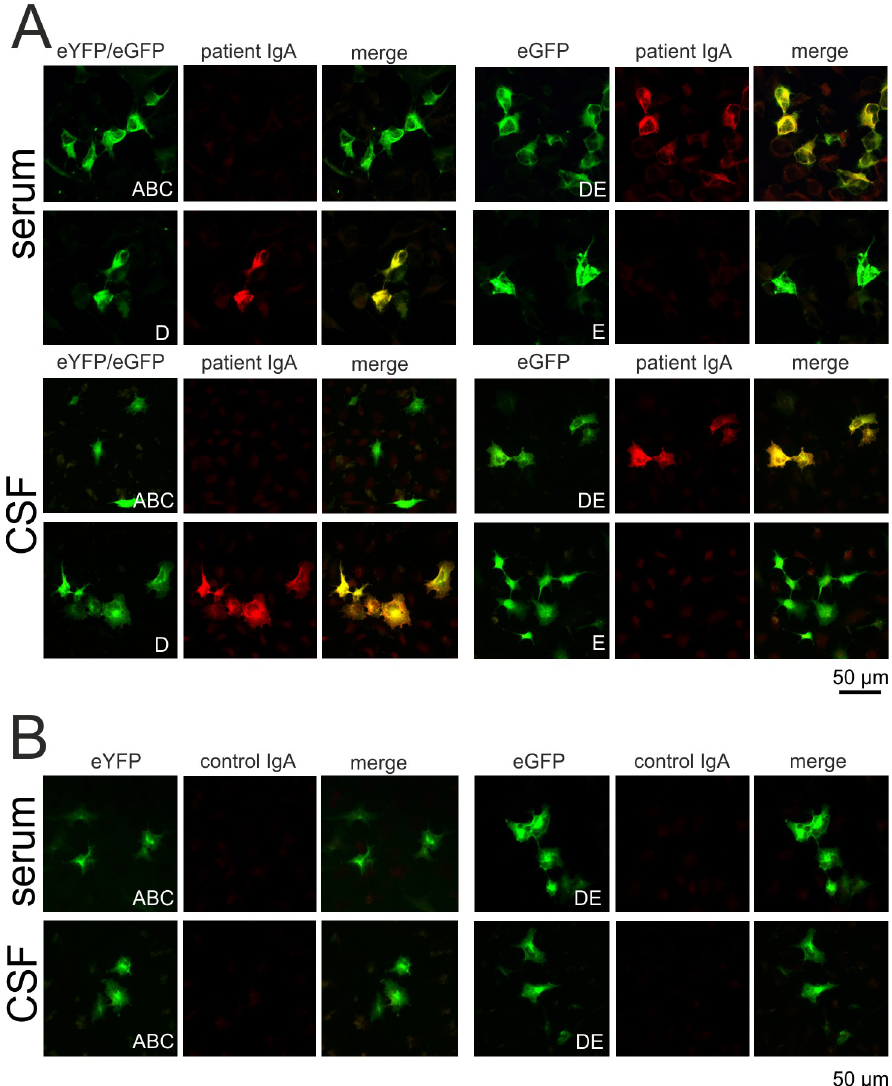
Fig 3. IgA antibodies to synapsin in serum and CSF of the previously described index patient with limbic encephalitis are directed against the D-domain of synapsin. (A)HEK293 cells were transfected with eYFP-tagged synapsin I fragment ABC, eGFP-tagged DE, D or E. Cells were incubated with patient serum or CSF at a dilution of 1:320. Bound patient IgA was detected using a Texas red-coupled secondary antibody directed against human IgA. Both the patient’s serum and CSF (Patient IgA) demonstrated positive immunoreactivity that co-localized with the eGFP tag of synapsin DE and single D fragments, but with none of the other constructs. (B) Serum and CSF of two healthy controls (control IgA) did not bind to the cells transfected in the same